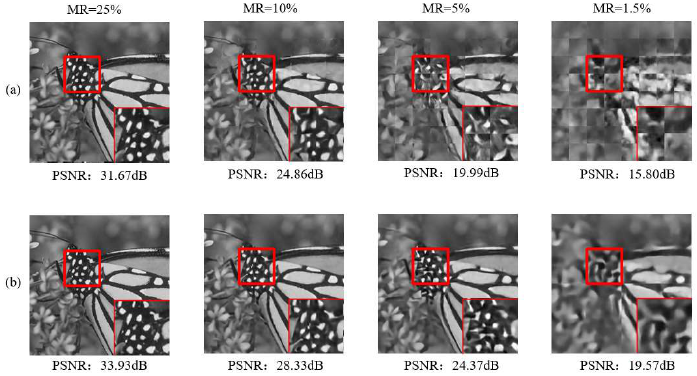
Figure 7. Reconstruction results using ISTA-Net+ and SRMU-Net. ( a ) Reconstructed by ISTA-Net+. ( b ) Reconstructed by